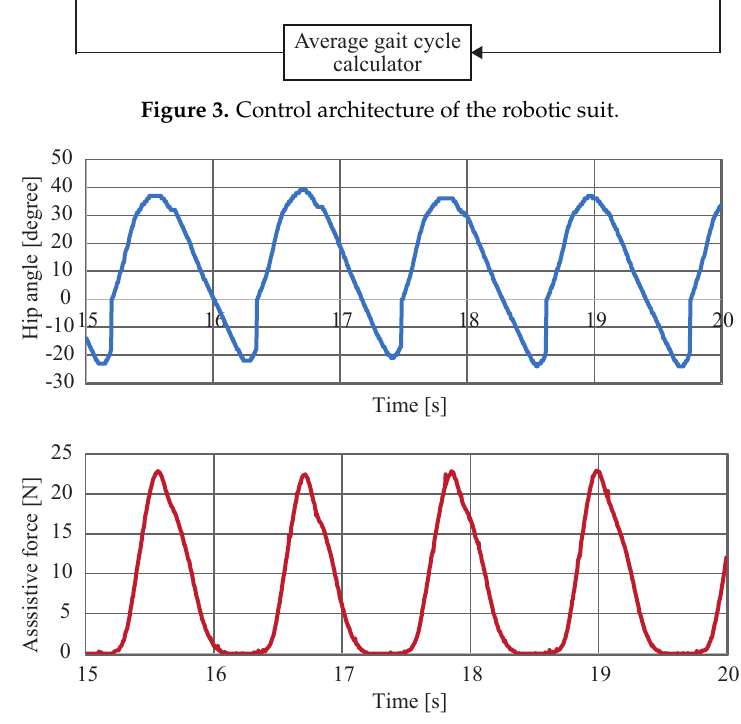
Figure 4. Measured hip angle and generated assistive